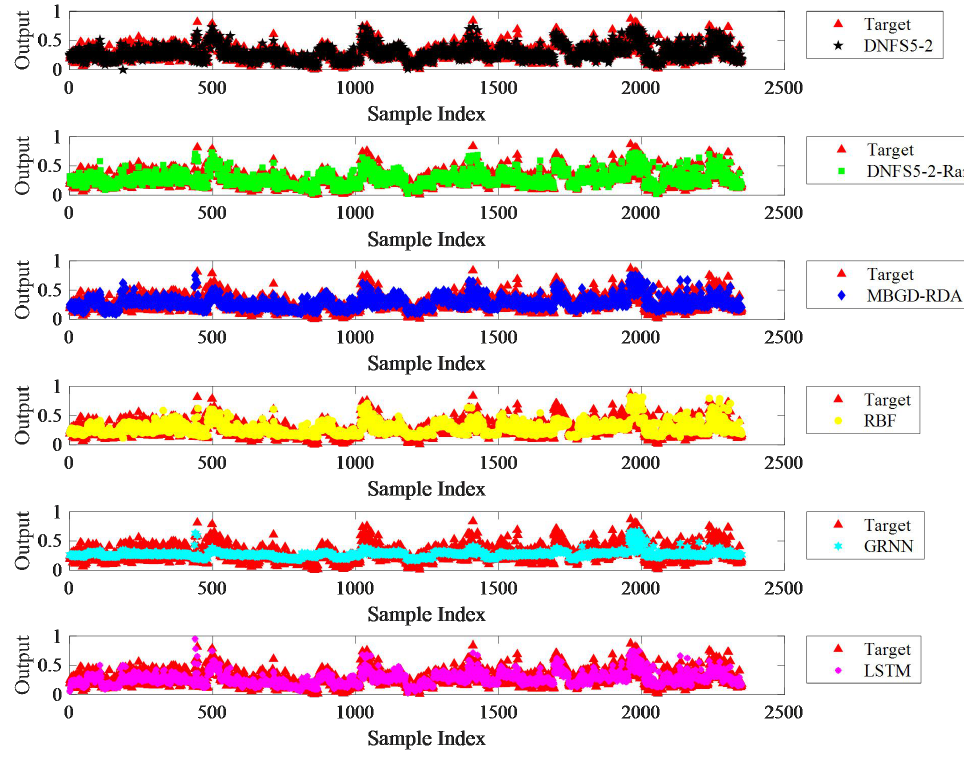
Figure 6. Prediction charts of different algorithms on Test Dataset No.